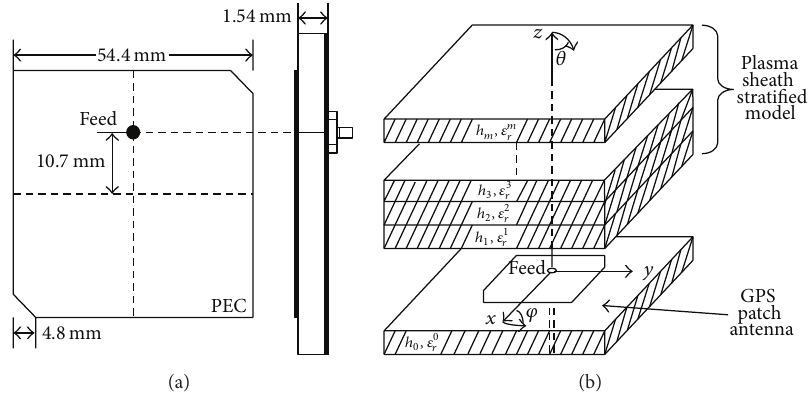
Figure 3: Plasma-covered antenna simulation models.